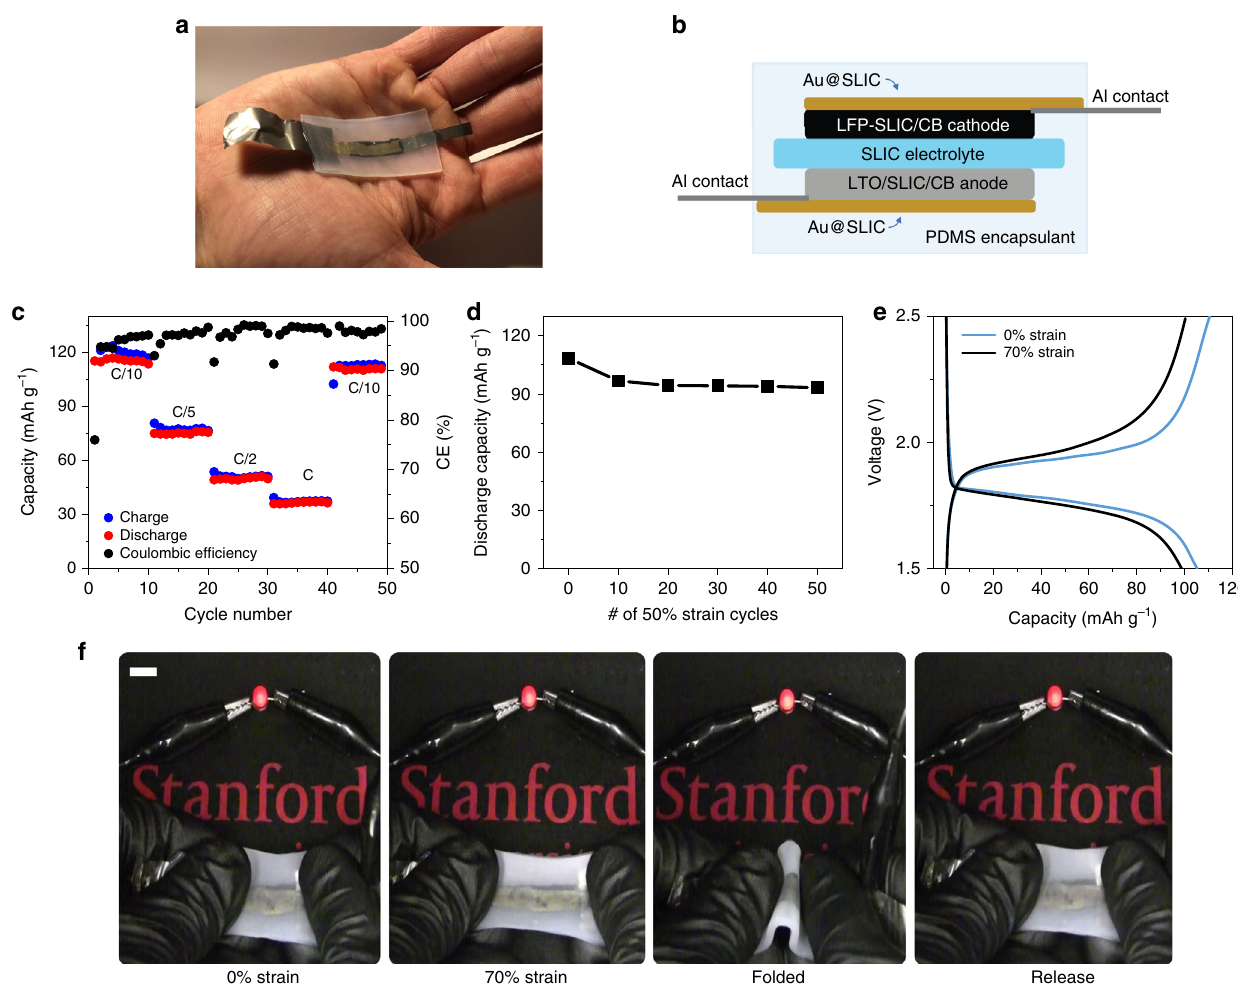
Fig. 5 Stretchable batteries based on SLIC. a Optical photograph of the conformable battery based on all SLIC components. b Cross-sectional view of the SLIC battery showing the layout of the components. c Capacity versus cycle number for a full-cell based on stretchable SLIC components. The active material loading in the electrodes (LFP or LTO) is 70 wt.%, ~1.1 mAh cm − 2 . d Discharge capacity of an all-SLIC stretchable battery after several cycles of 50% strain. Discharge capacity is measured after each set of 10 stretching cycles. e Performance of an all-SLIC stretchable battery under 0 and 70% strain. f Demonstration of a stretchable SLIC battery providing power to a red LED under no strain, stretched 70%, folded, and returned to its original